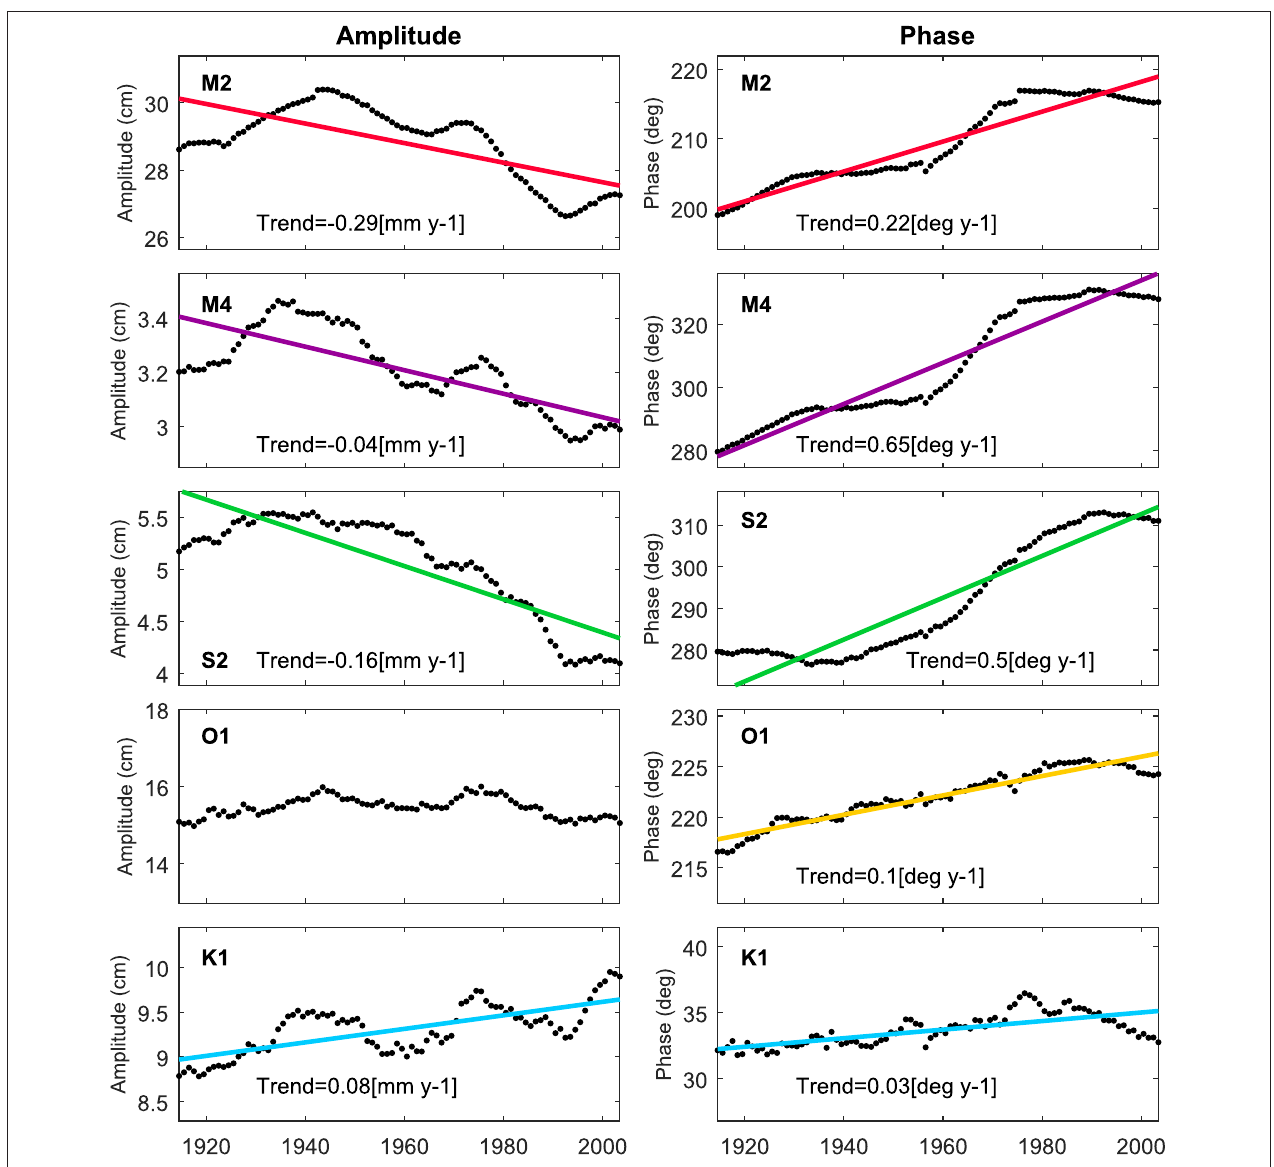
FIGURE 6 | Variability and linear trends of the amplitude and phase of the main tidal constituents of Buenos Aires (only significant trends are